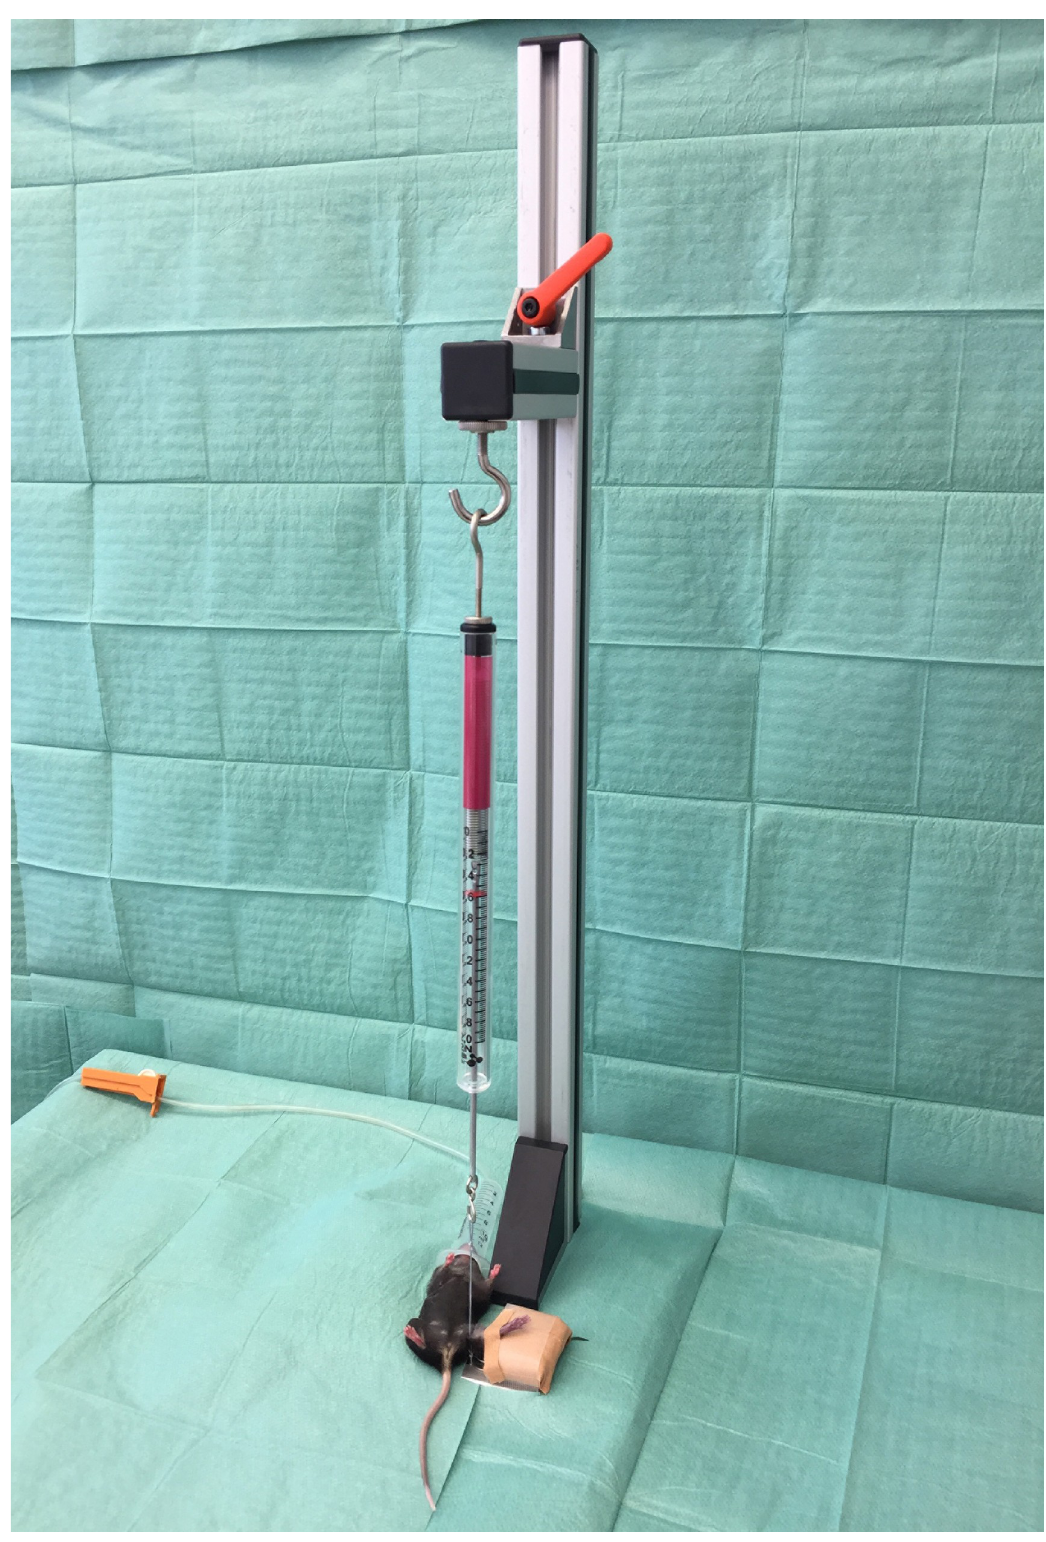
Fig 1. Low-pressure